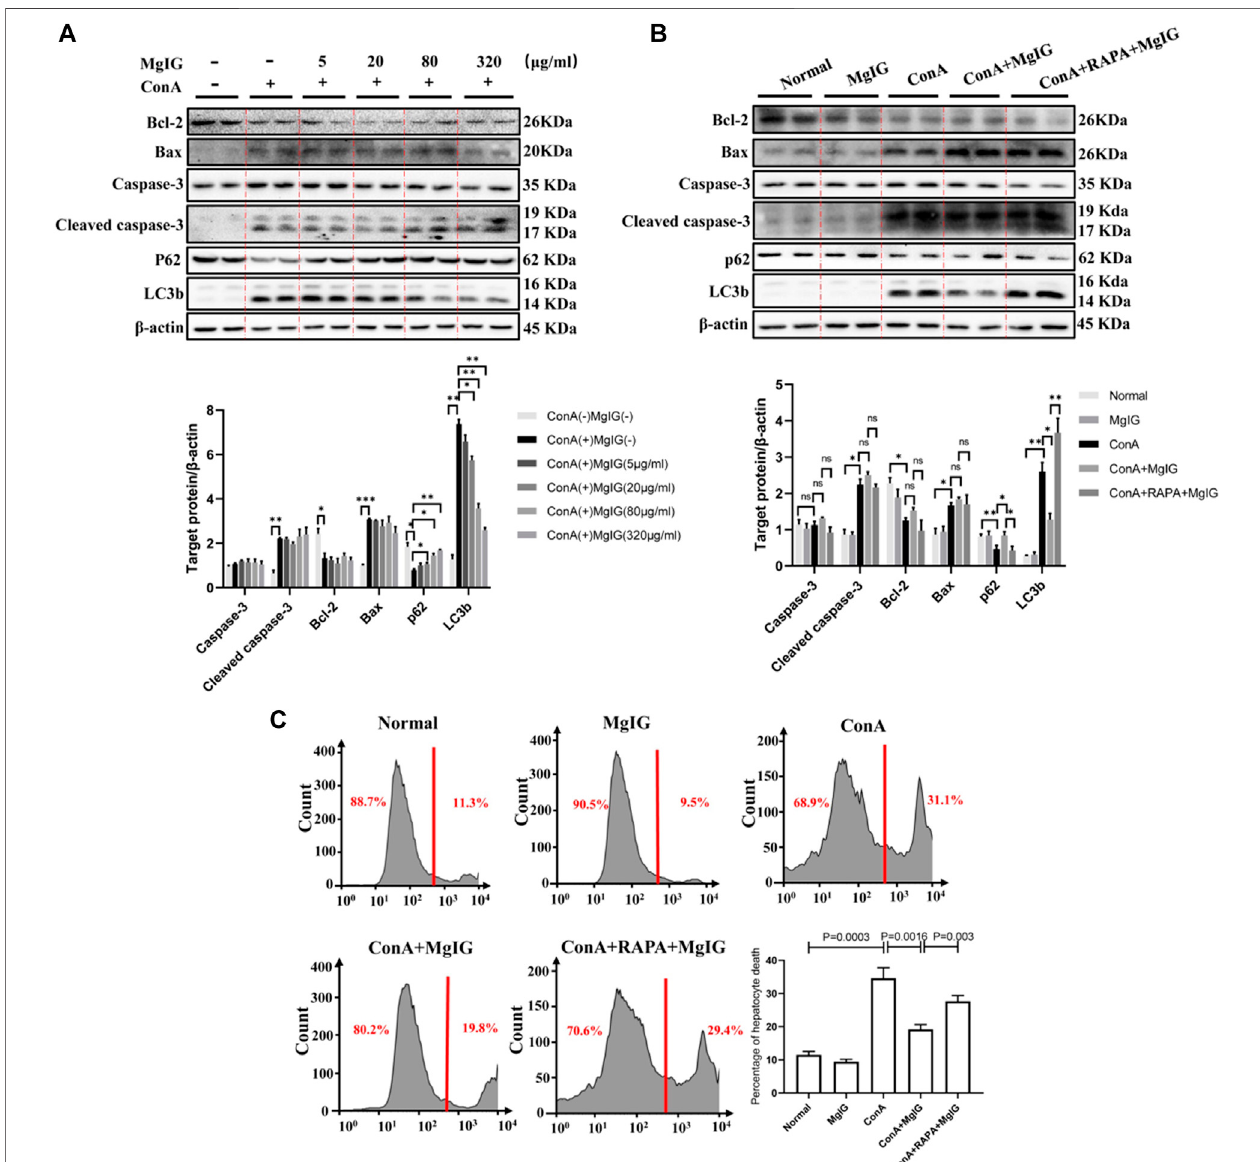
FIGURE 5 | MgIG reduces hepatocyte death by inhibiting autophagy in vitro . The data are shown as the mean and SD of at least three independent experiments. (A) TheeffectsofdifferentconcentrationsofMgIG(5,20,80,320 μ g/ml)onprotein (caspase-3, cleaved caspase-3,Bax,Bcl-2,P62and LC3b)expression levels invitro were determined by western blotting, with β -actin as a control ( *** p < 0.001, ** p < 0.01, * p < 0.05). (B) The protein expression levels of caspase-3, cleaved caspase-3, Bax, Bcl-2, p62 and LC3b in the normal control, MgIG (80 μ g/ml) control, ConA (20 μ g/ml) model, MgIG (80 μ g/ml) treatment and RAPA (10 μ g/ml) intervention groups were determined by western blotting, with β -actin as a control (** p < 0.01, * p < 0.05). (C) Hepatocytes were stained with SYTOX ® Green Nucleic Acid staining reagent in vitro , and hepatocyte mortality was measured and quanti fi ed by fl ow